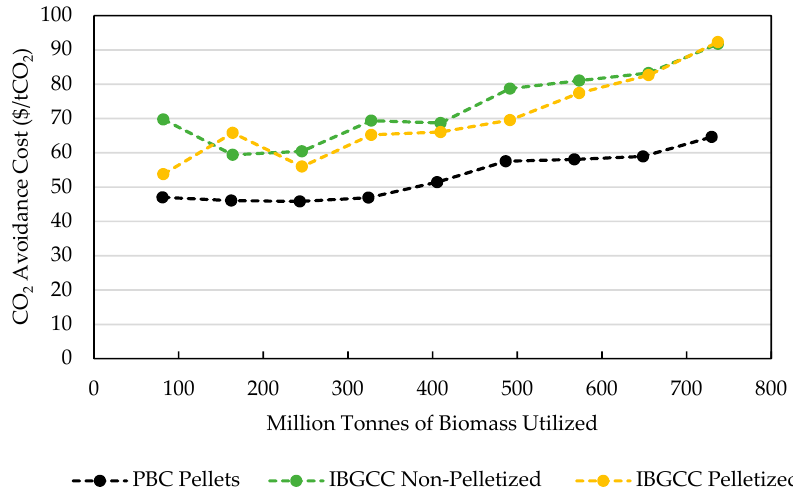
Figure 5. CO 2 avoidance costs (in $ per tonne of CO 2 avoided) using an NGCC power plant without CCS as the reference case for CAC calculations.